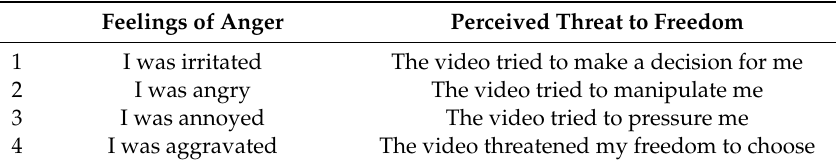
Table 2. Items for both reactance scales.